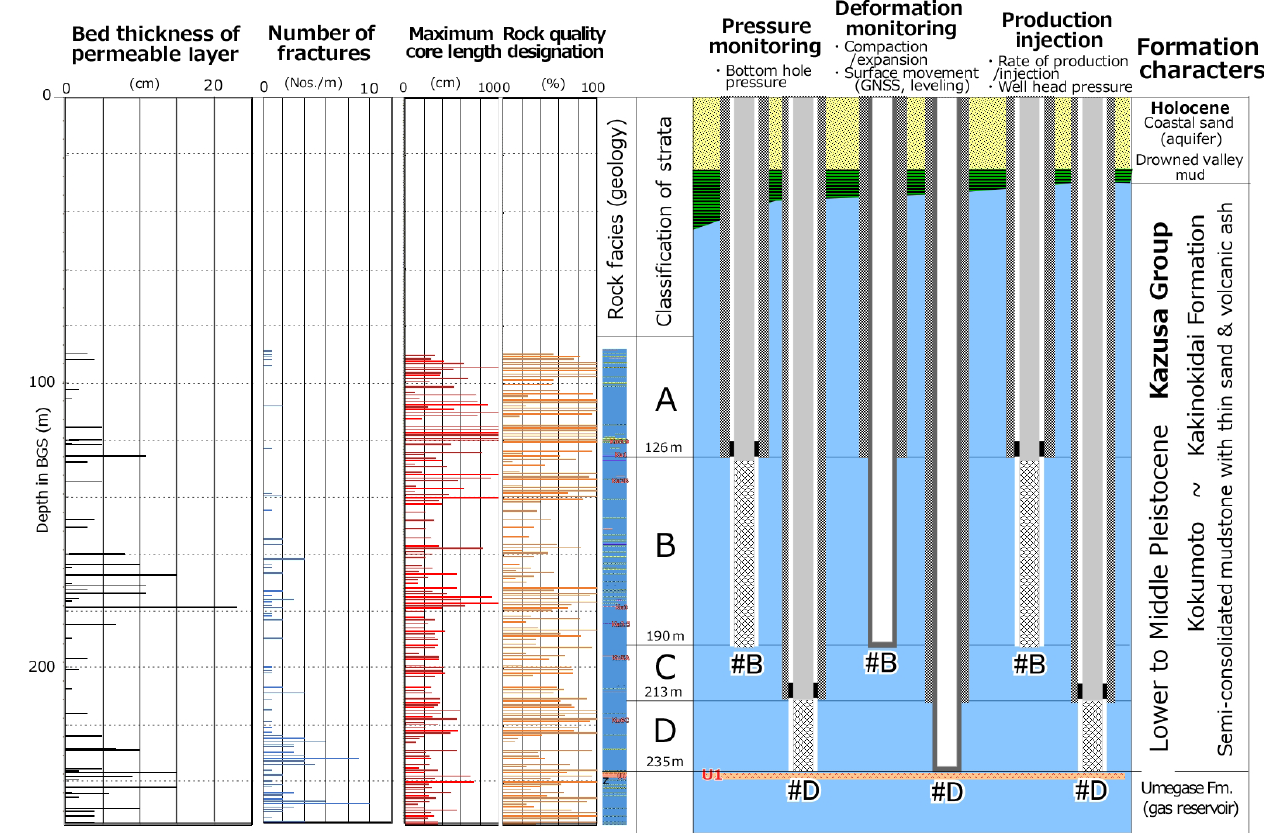
Figure 2. Geological characterization and the well completion of the pilot